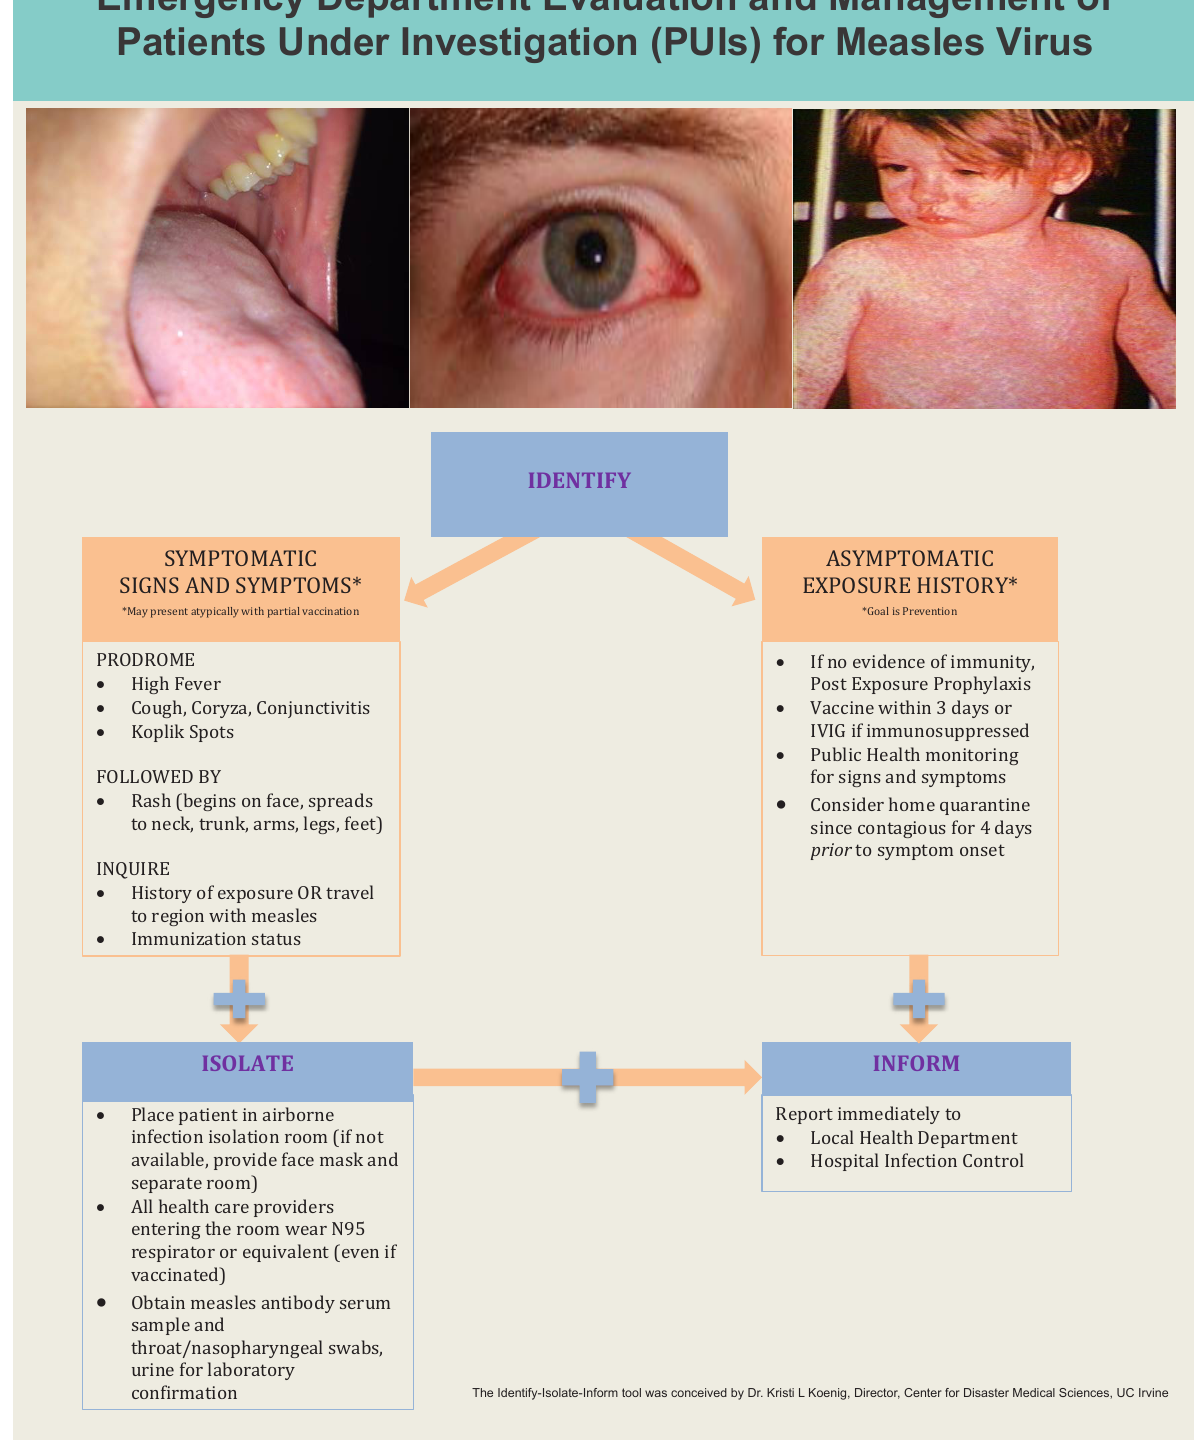
Figure 6. Identify, isolate, and inform tool. IVIG, intravenous